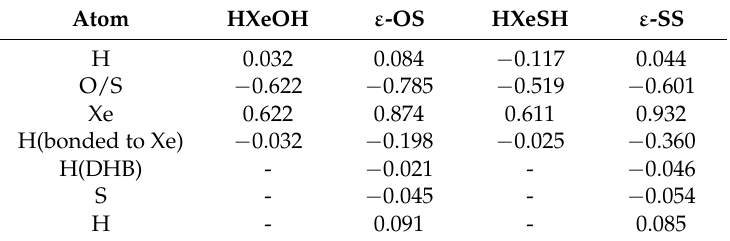
Table 1. MP2/aug-cc-pVDZ(-PP) computed Mulliken charges for the HXeOH/HXeSH) molecules and their dihydrogen bonded complexes with H 2